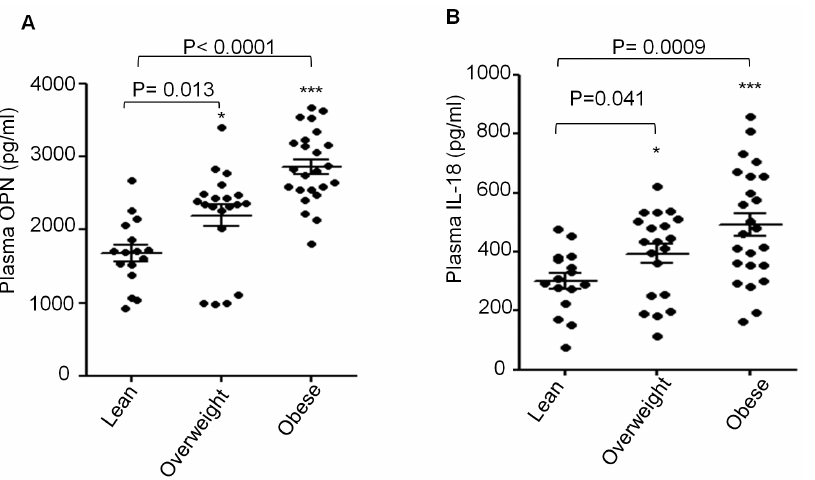
Figure 1. Plasma levels of OPN and IL-18 in obese individuals. 60 plasma samples from obese (n: 24), overweight (n: 20) and lean individuals (n: 16) were analyzed for expression of the circulating OPN (A) and IL-18 (B). Each dot represents the individual value of OPN and IL-18. Lines represented the mean values of plasma OPN and IL-18 of each group with 6 SE.